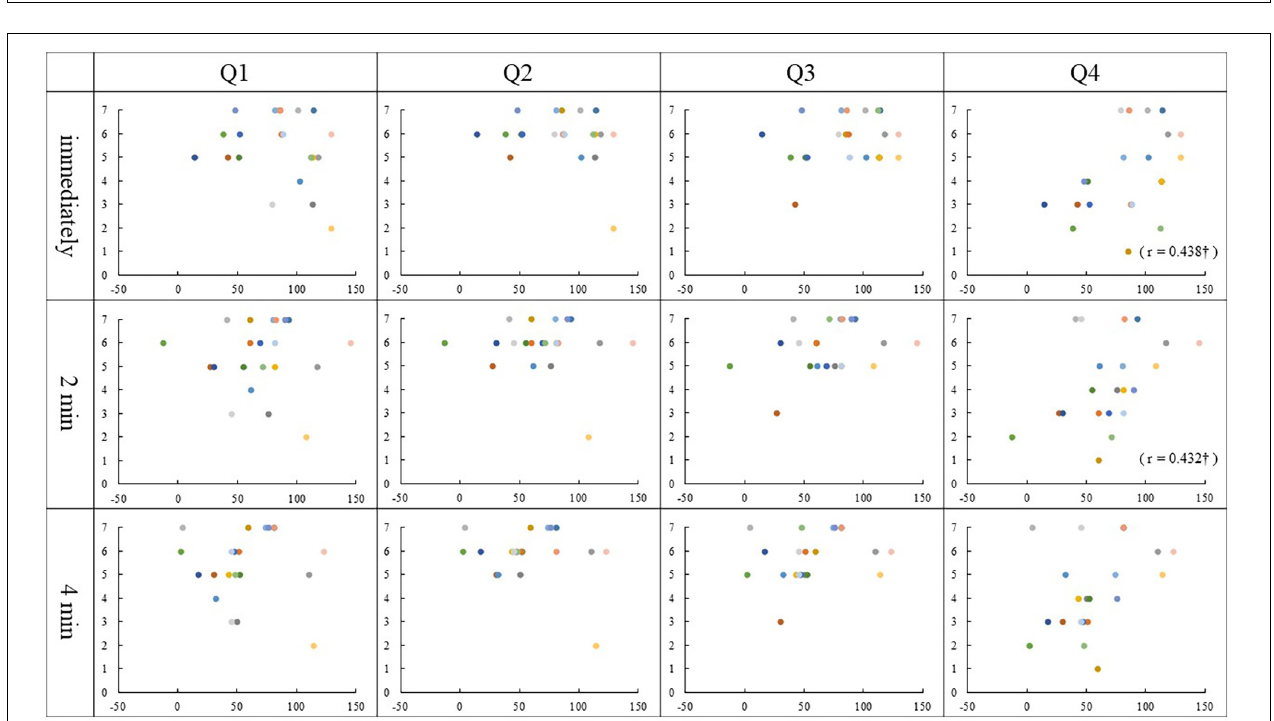
FIGURE 4 | Relationship between PD values and Questionnaire in the synchronous condition: The vertical and horizontal lines indicate the rating scale and the PD value, respectively. The PD values were calculated by subtracting each position after stimulation from the baseline (mm). † p =